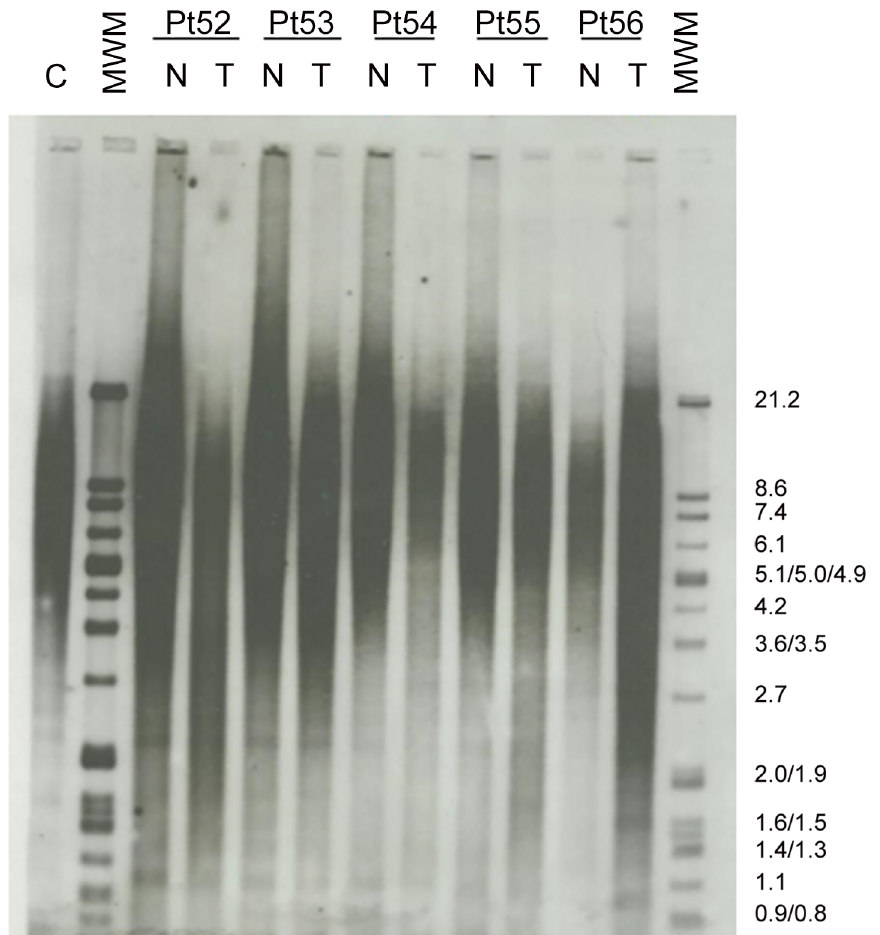
Fig 1. Results of a representative x-ray film for telomere length analysis from five colorectal cancer patients (Pt) in tumour tissues (T) and their paired non-tumour samples (N). C, positive control. MWM, DNA molecular weight